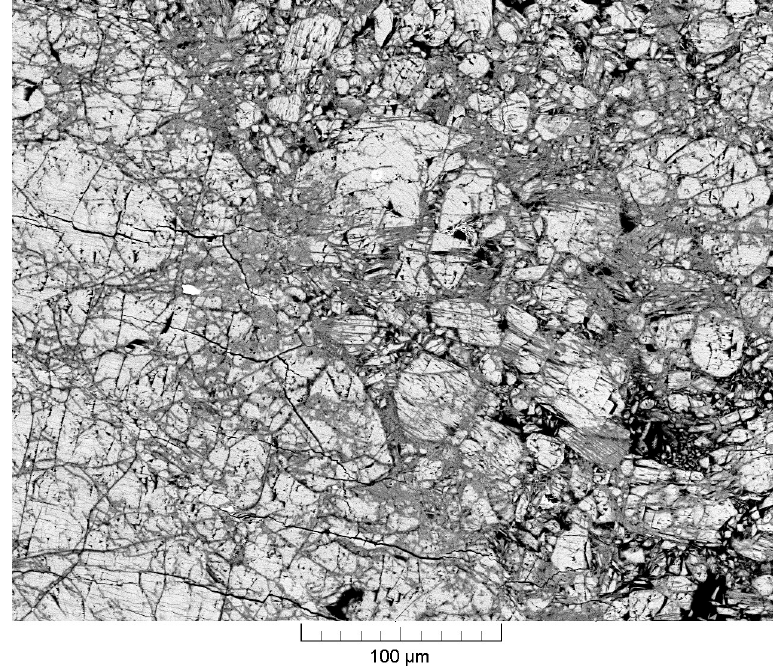
Figure 1. Image of Sample II in back-scattered electrons. The zones 1 and 2 are light gray and dark gray, respectively. Table 3. Chemical composition (wt. %) of initial and Ag-exchanged elpidite samples.